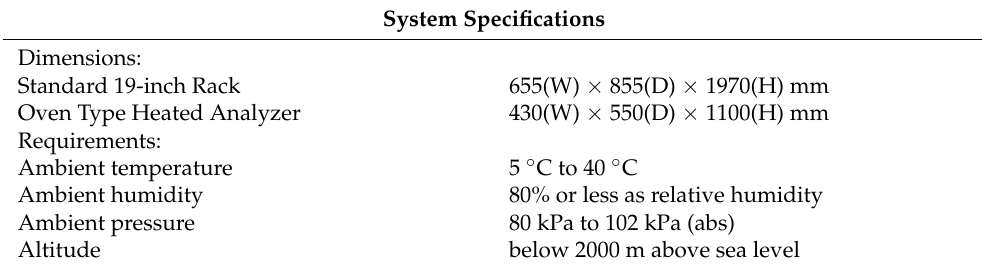
Table A6. Horiba MEXA-ONE System Specifications (Source: Horiba).